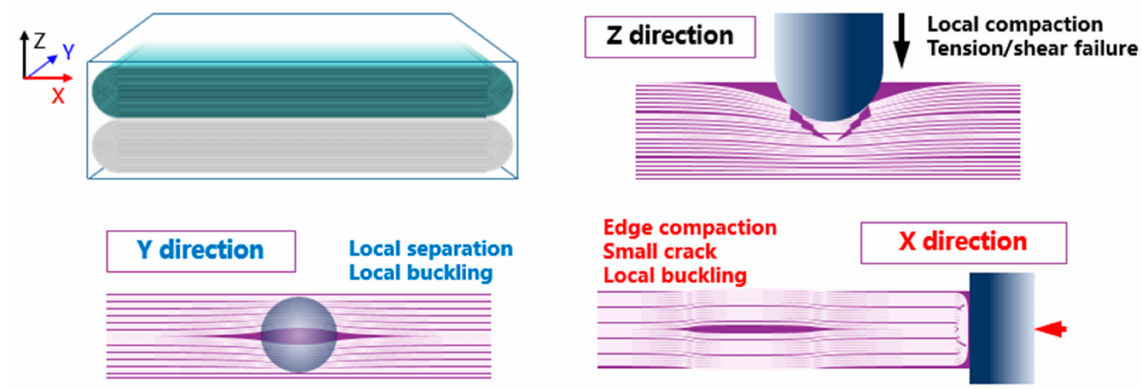
Figure 3. Deformation modes of indentation tests along different directions.